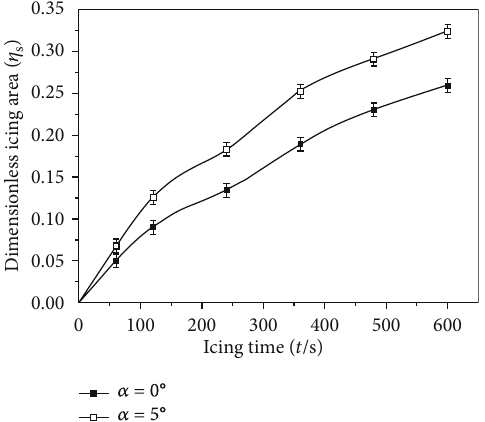
Figure 18: Dimensionless icing area in static